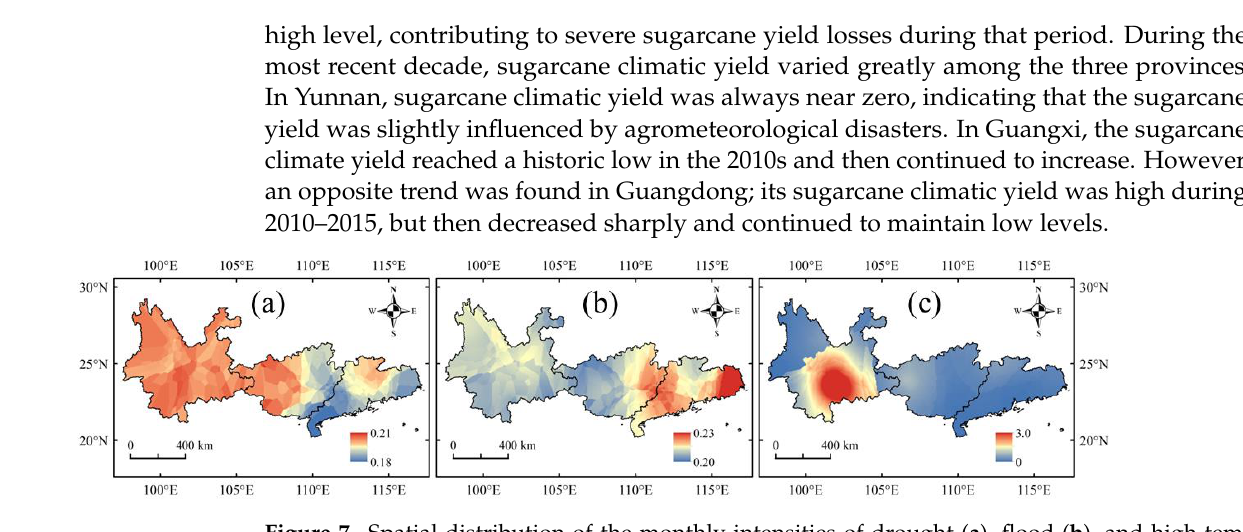
Figure 7. Spatial distribution of the monthly intensities of drought ( a ), flood ( b ), and high temperatures ( c ) during the entire sugarcane growing season in southern China. The intensities were averaged over 1970 – 2020 and displayed here for spatial analysis.